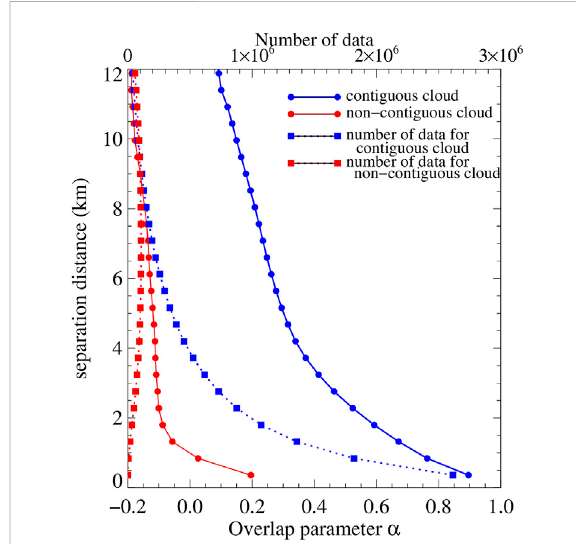
FIGURE 1 Globally-averaged α , the weighting (overlap) parameter regulating the mixing of maximum and random cloud occurrence overlap of two cloudy layers ( α = 1: maximum overlap; α = 0: random overlap ; α < 0: minimum overlap), as a function of separation distance Δ z , derived from the O22 COD cloud fi elds. We show results for two cases, one where cloud is also encountered in all intervening layers ( “ contiguous cloud, ” solid blue curve and circle symbols), and one where the intervening layers can contain clear skies ( “ non-contiguous cloud, ” solid red curve and circle symbols). The number of data points used to derive the pro fi les for each case are shown with the dotted curves using the same color convention and square